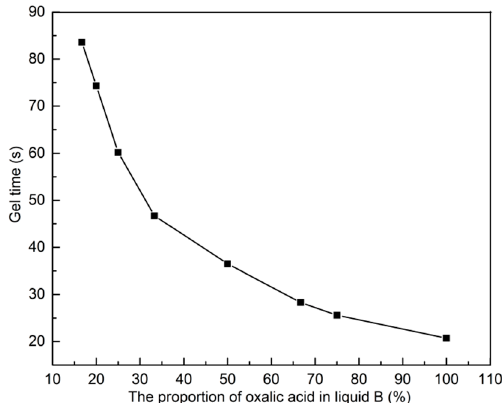
Figure 1. The relationship between gel time and the concentration of oxalic acid in liquid B.